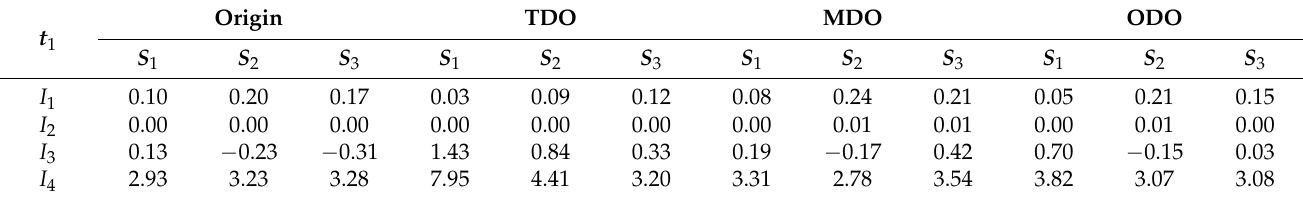
Table 2. Central moments I 1 to I 4 of MMT parameters t 1 for bovine tendon tissue